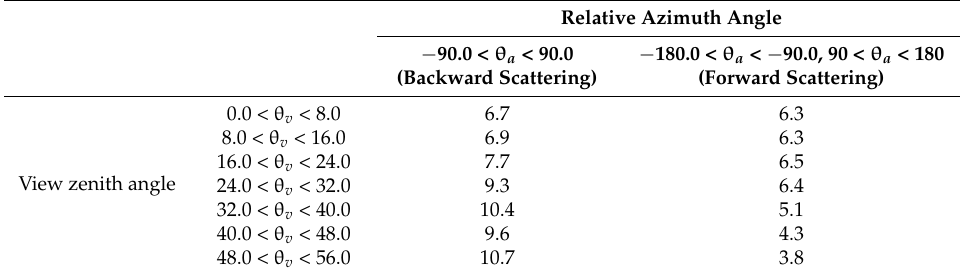
Table 1. Percentage for the number of pairs of MODIS and VIIRS reflectance spectra in each angular condition.